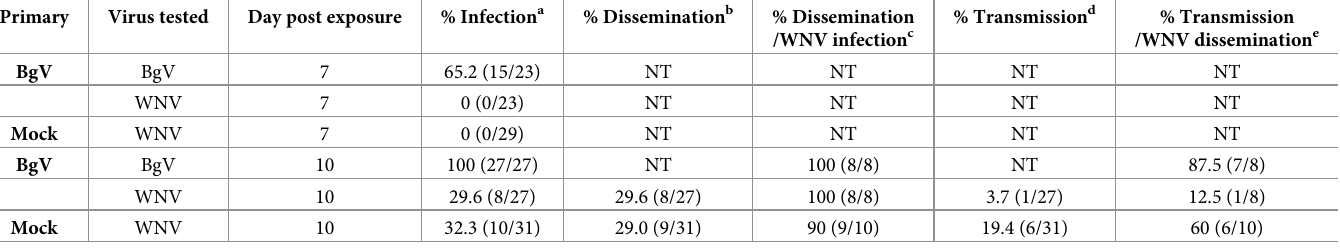
Table 4. Infection, dissemination and transmission rates of WNV and BgV in Culex mosquitoes primarily mock- or BgV-injected and super-infected with WNV via bloodfeeding. NT = Not